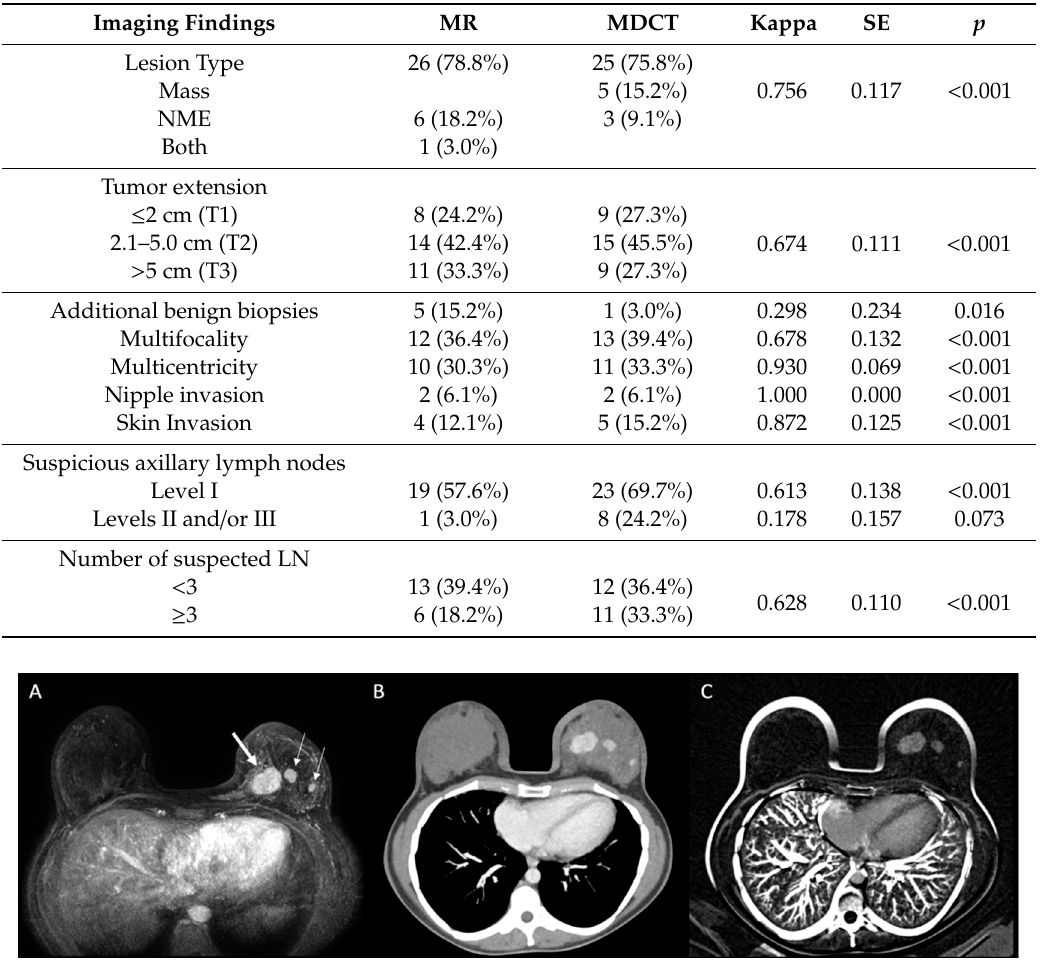
Table 1. Imaging findings on breast MRI and MDCT in breast cancer patients ( n = 33).